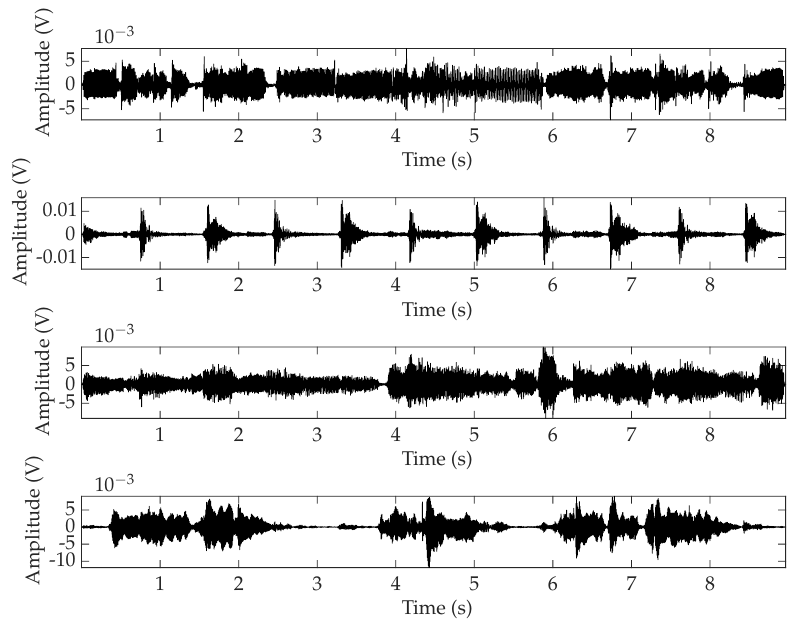
Figure 8. Redress Source Estimates: bass (row 1), drums (row 2), other instruments (row 3), voice (row